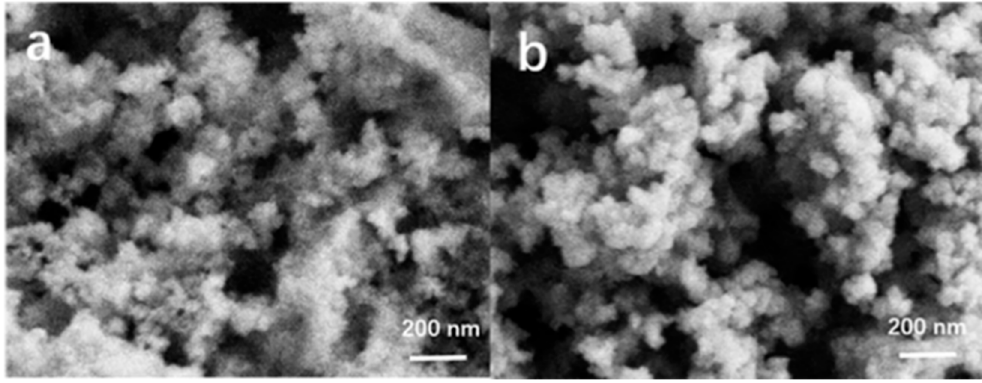
Figure 2. Scanning electron microscopy (SEM) images of sample ( a ) SiAl-1 and ( b ) SiAl-2.